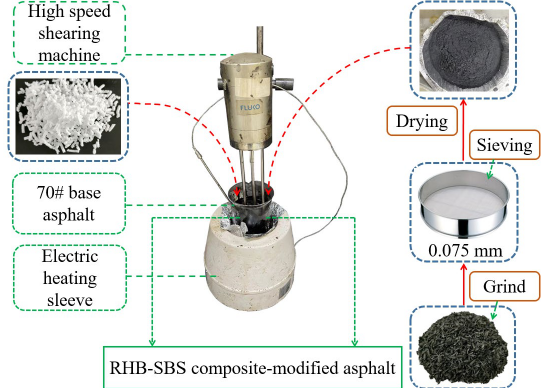
Figure 2. Flow chart of preparation of composite-modified asphalt.